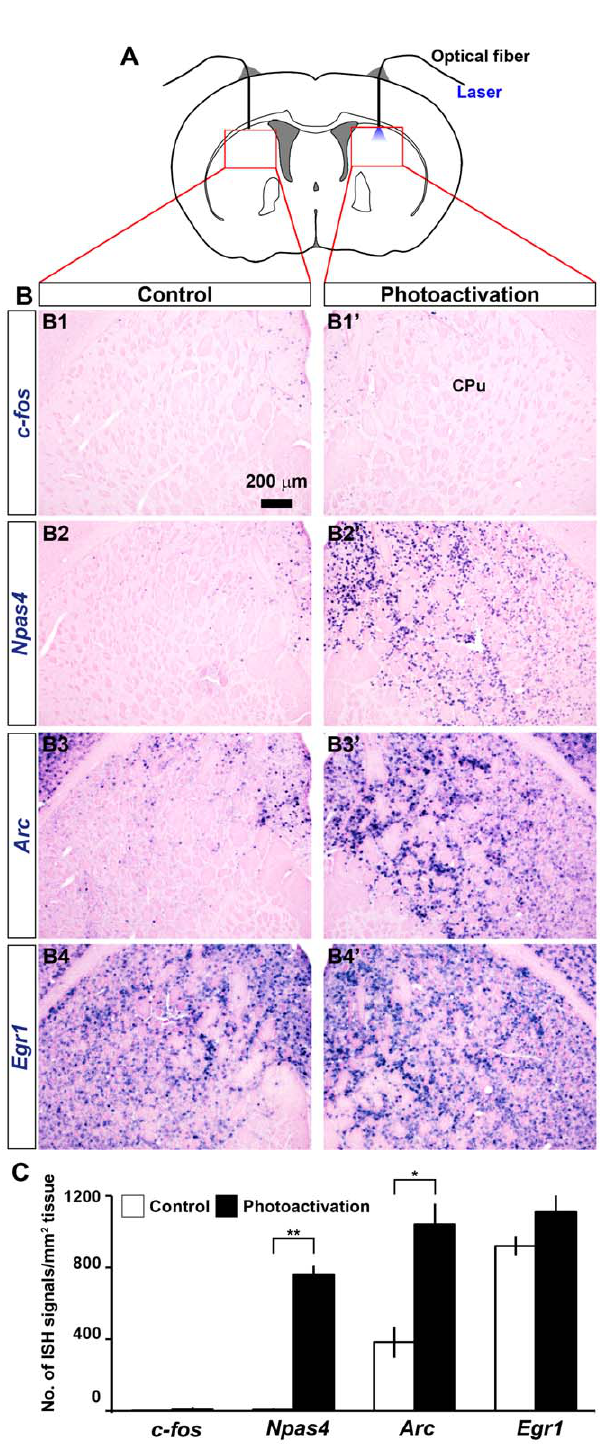
Figure 2. Identification of photoactivated neurons by IEG tracing. (A) Schematic used for in vivo photostimulation and histology in the mouse striatum. Blue light stimulation was given to the left striatum and the right striatum was used as the sham-treated control. Boxed areas indicate approximate striatal regions shown in B. (B) Representative images of coronal tissue sections from mice which received optogenetic stimulation in the left striatum showing ISH signals of c-fos (B1, B1’), Npas4 (B2, B2’), Arc (B3, B3’) and Egr1 (B4, B4’). CPu, Caudate putamen. (C) Quantification of c-fos , Npas4 , Arc and Egr1 mRNA signals in the striatum after light stimulation. Induction of c-fos was not observed, whereas, a robust increase in Npas4 mRNA signals